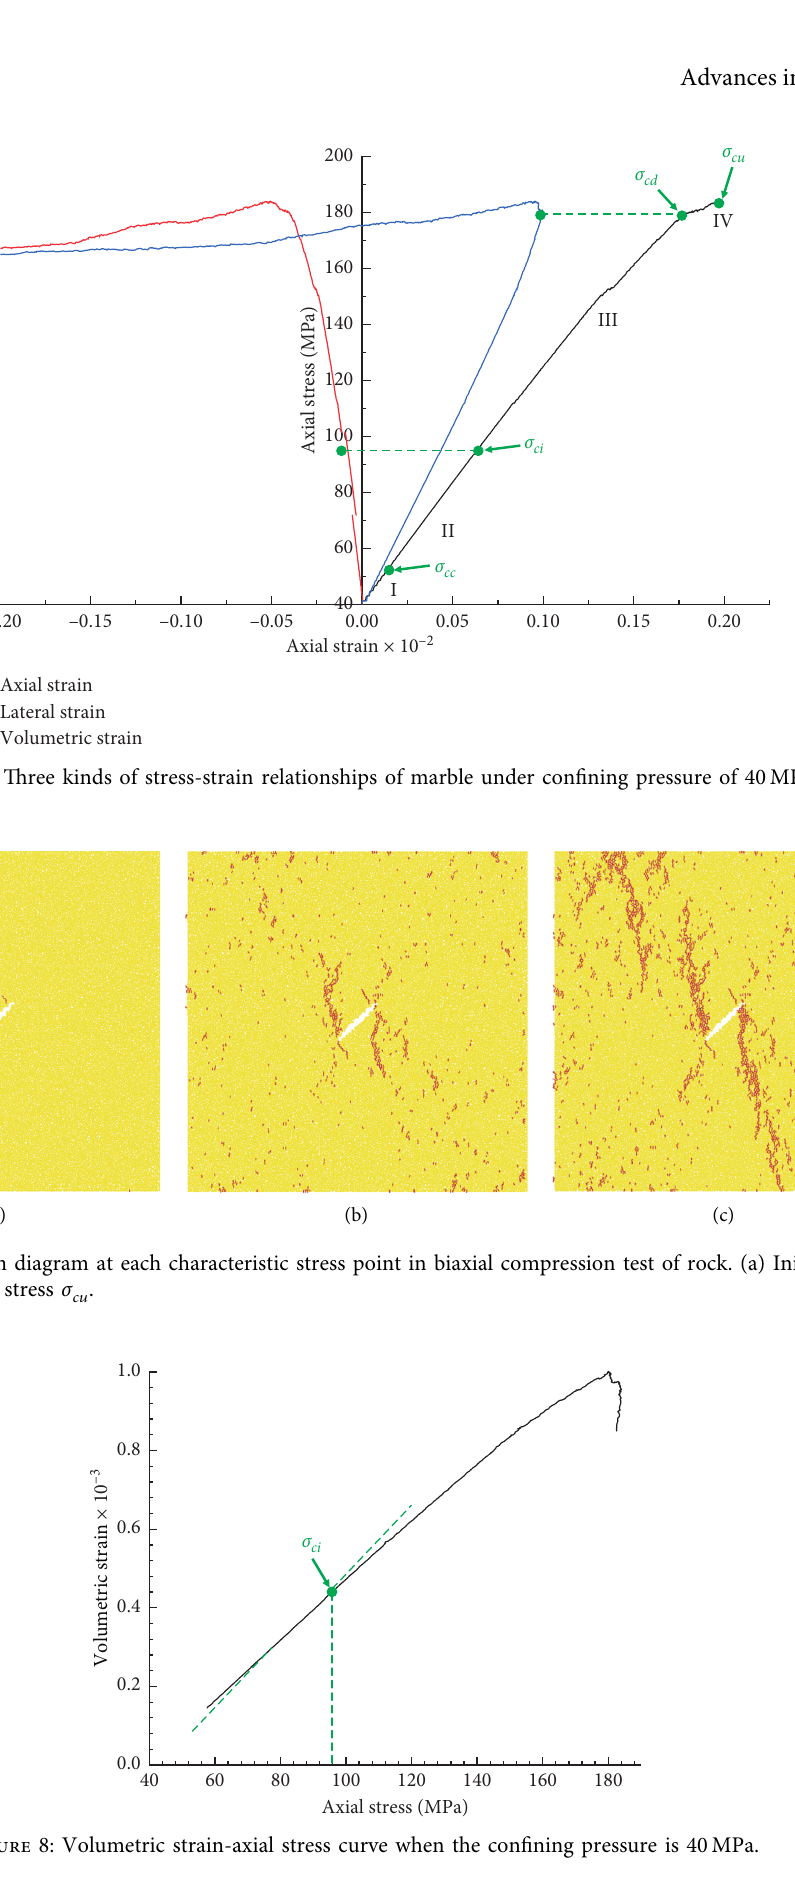
Figure 8: Volumetric strain-axial stress curve when the confining pressure is